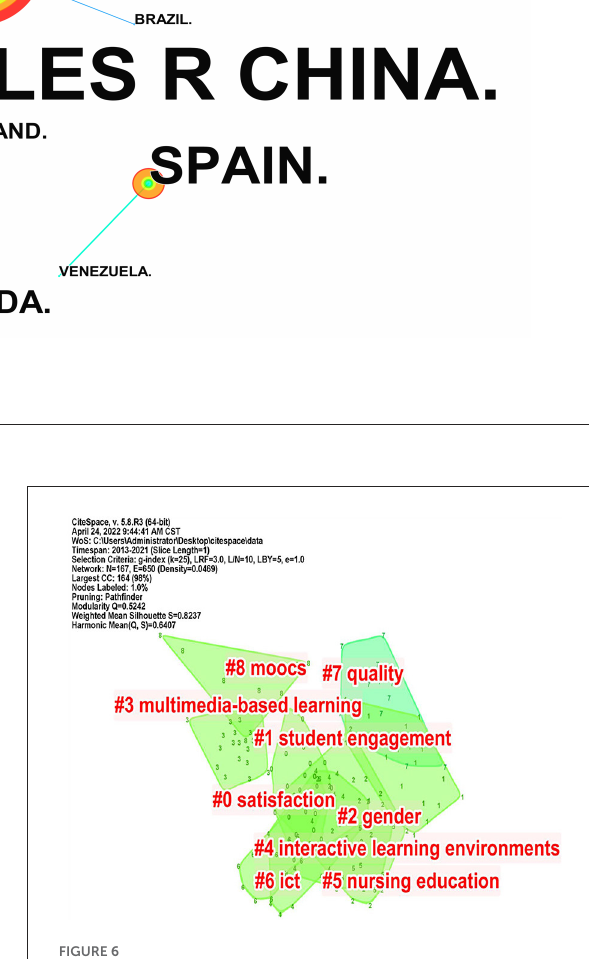
FIGURE6 Keywords clustering mapping knowledge